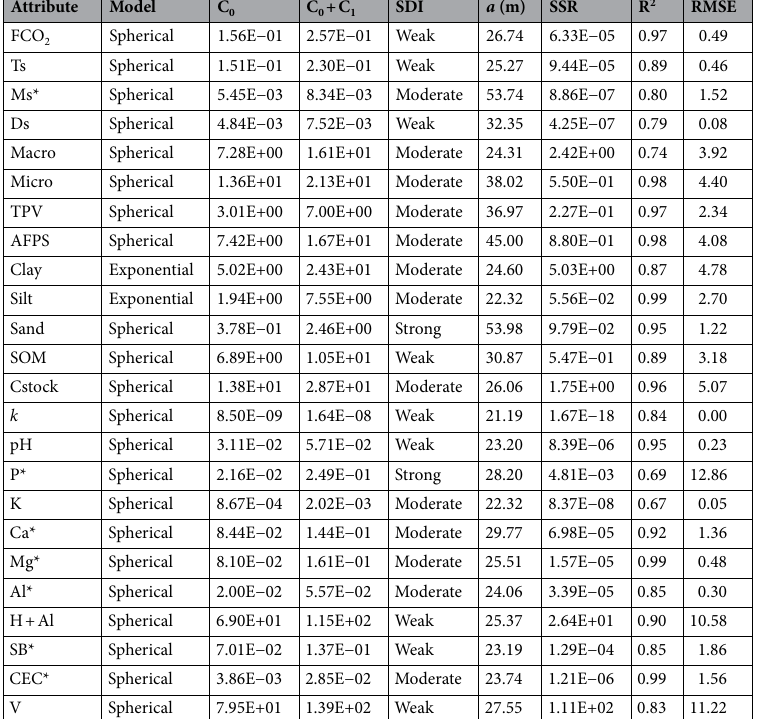
Table 3. Models and parameters adjusted to the experimental variograms of soil attributes. N = 100; *Logarithmic transformation;